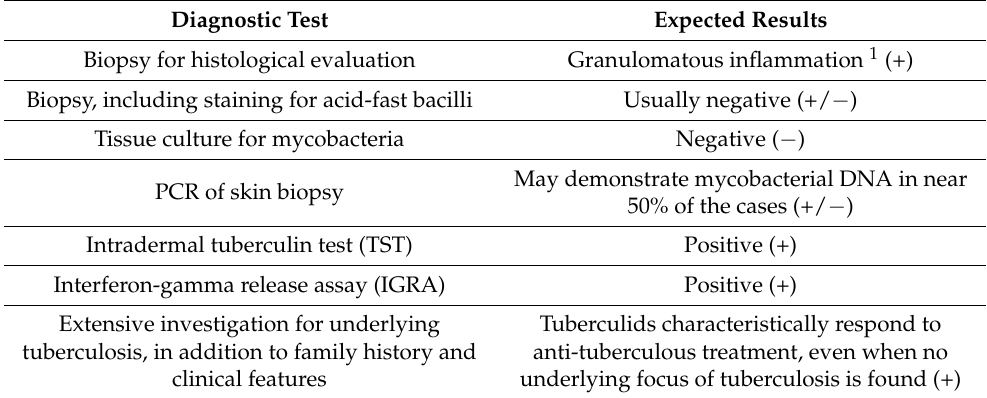
Table 1. Diagnostic strategies for tuberculids. Diagnostic